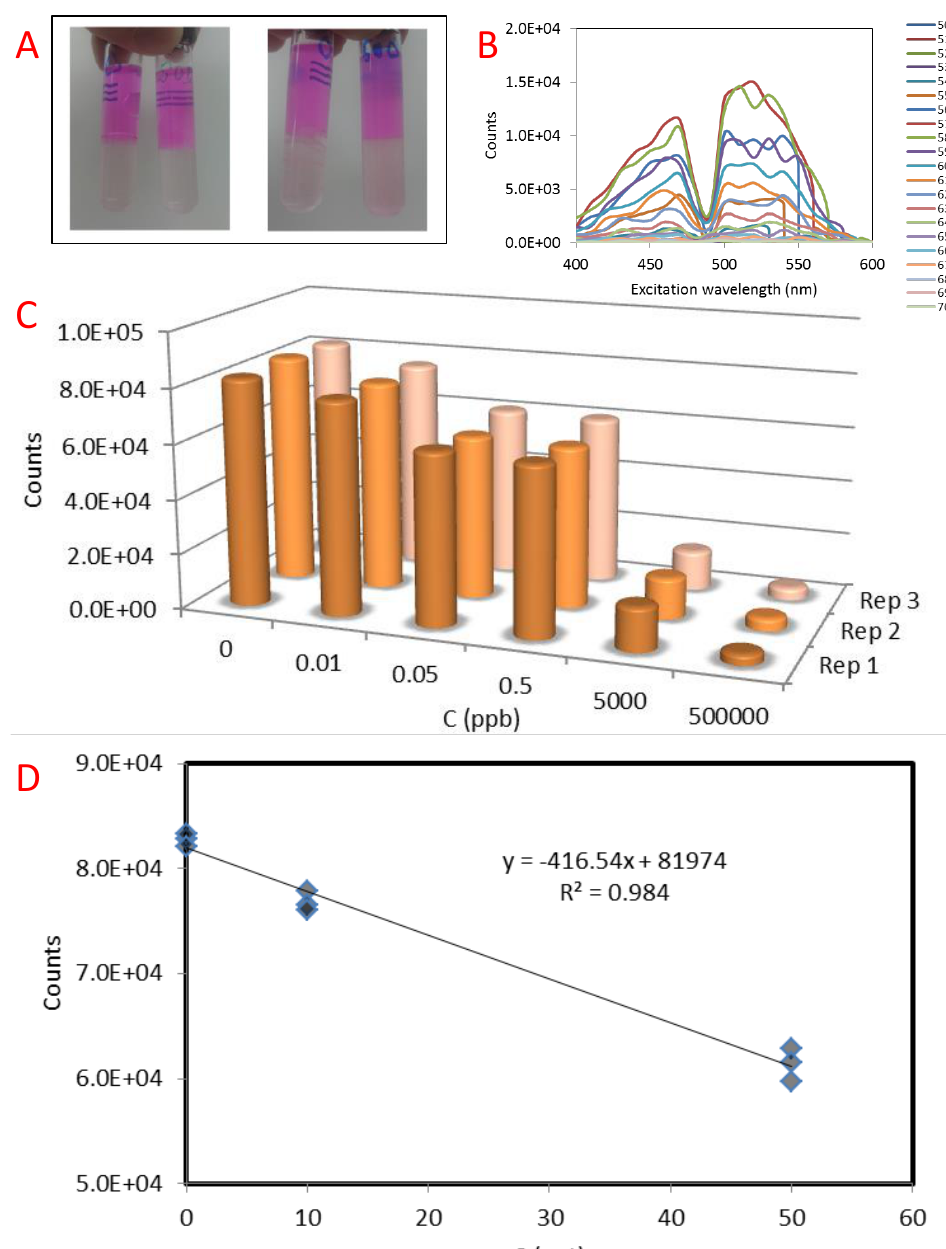
Figure 3. ( A ) Naked eye detection of 500 ppt Pb 2+ (left tube), and with less sensitive Lead IV ionophore (right) as comparison. ( B ) Finding optimized fluorescence wavelengths. ( C ) Repeatability at different concentrations, first repetition on each concentration in dark orange, second in medium orange and third in light orange. ( D ) Low ppt level calibration curve for the optimized Ex480/Em580 wavelengths. Limits of detection (LOD) = 3 ppt LOQ = 10 ppt.